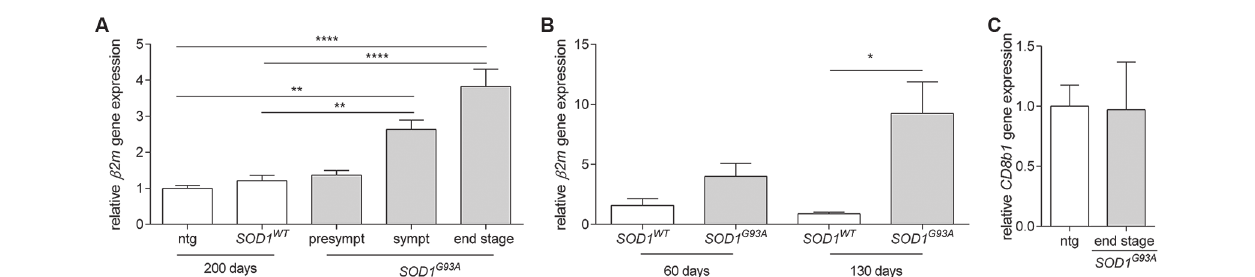
of SOD1 WT controls at 60 days ( n = 2) and 130 days of age ( n = 3) compared to neurons from SOD1 G 93 A mice at 60 days ( n = 3) and 130 days of age ( n = 3; Student’s t -test). (C) Relative CD8b1 gene expression in the spinal cord of 150 day old non-transgenic mice (ntg, n = 5) and end stage ( n = 5) SOD1 G 93 A mice. * p < 0.05, ** p < 0.01, **** p < 0.0001.